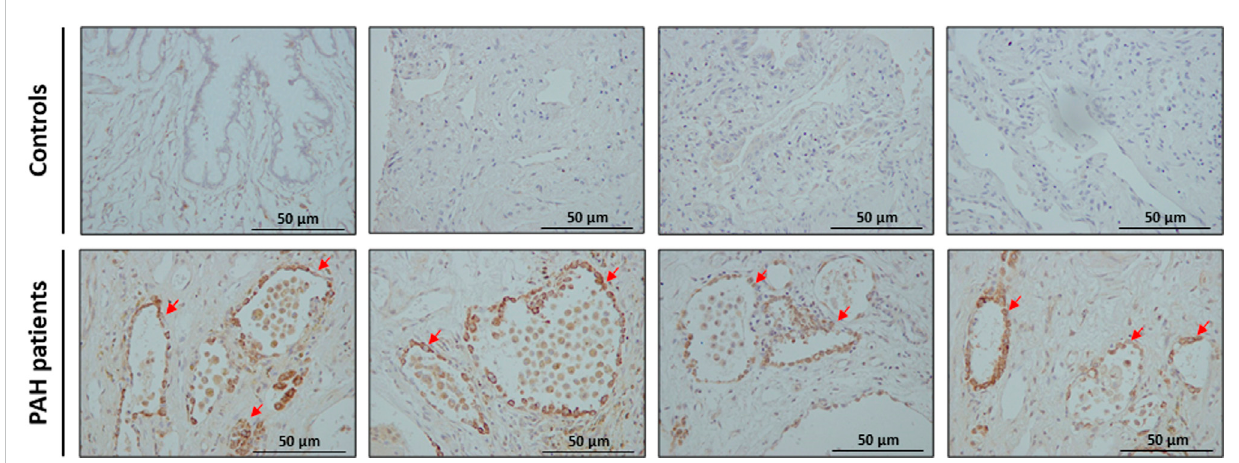
FIGURE 7 Expression of survivin in pulmonary arteries of patients with PAH. Representative photomicrographs showing immunohistochemical staining and